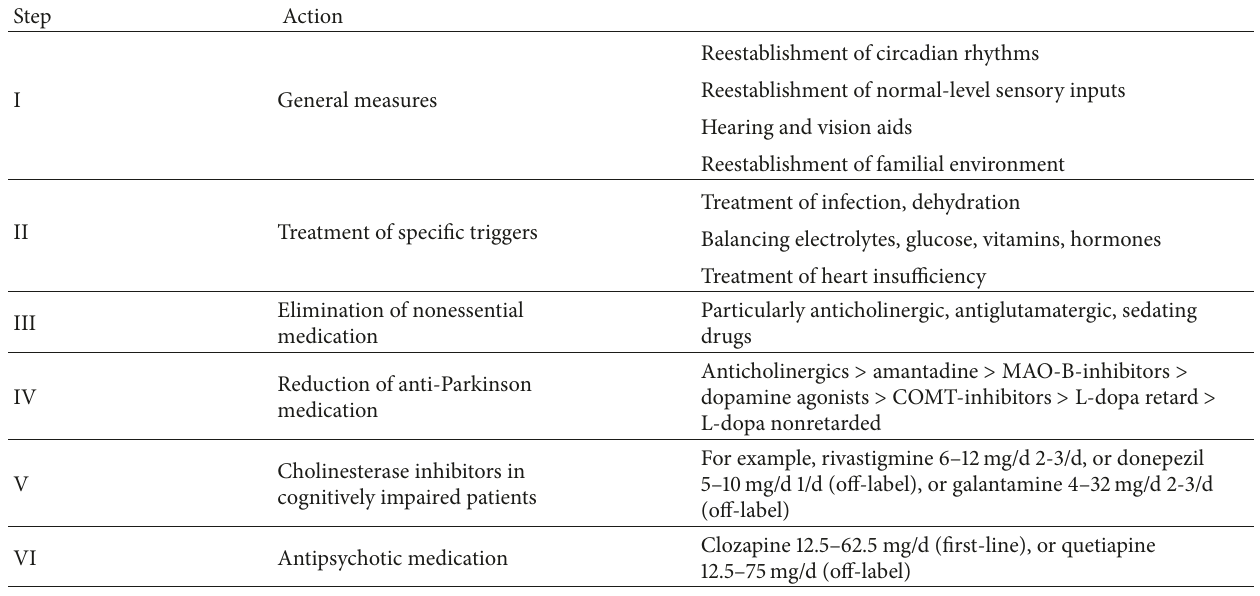
Table 5: Proposed treatment strategies of acute, secondary psychosis in Parkinson’s disease.